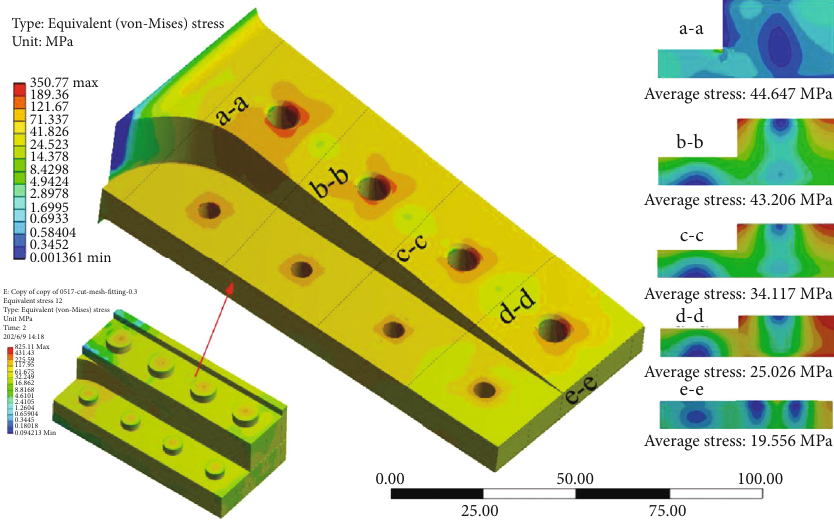
Figure 12: The stress state of the outer wing segment in the 10th segment